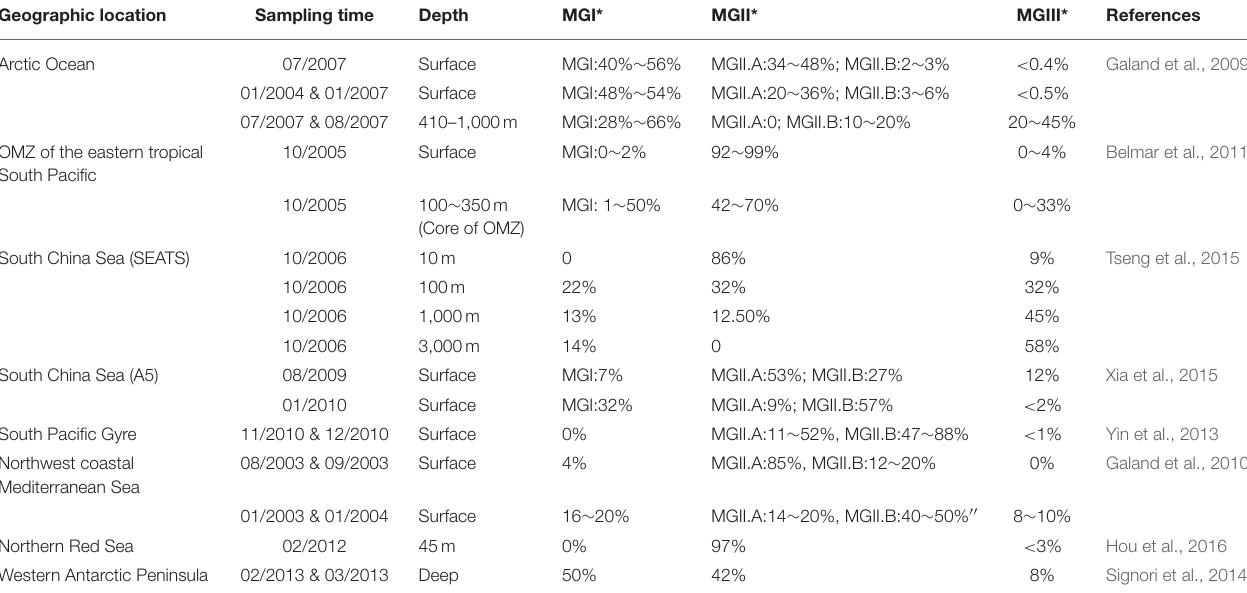
TABLE 5 | Comparison of archaeal assemblage composition in different geographic locations. Geographic